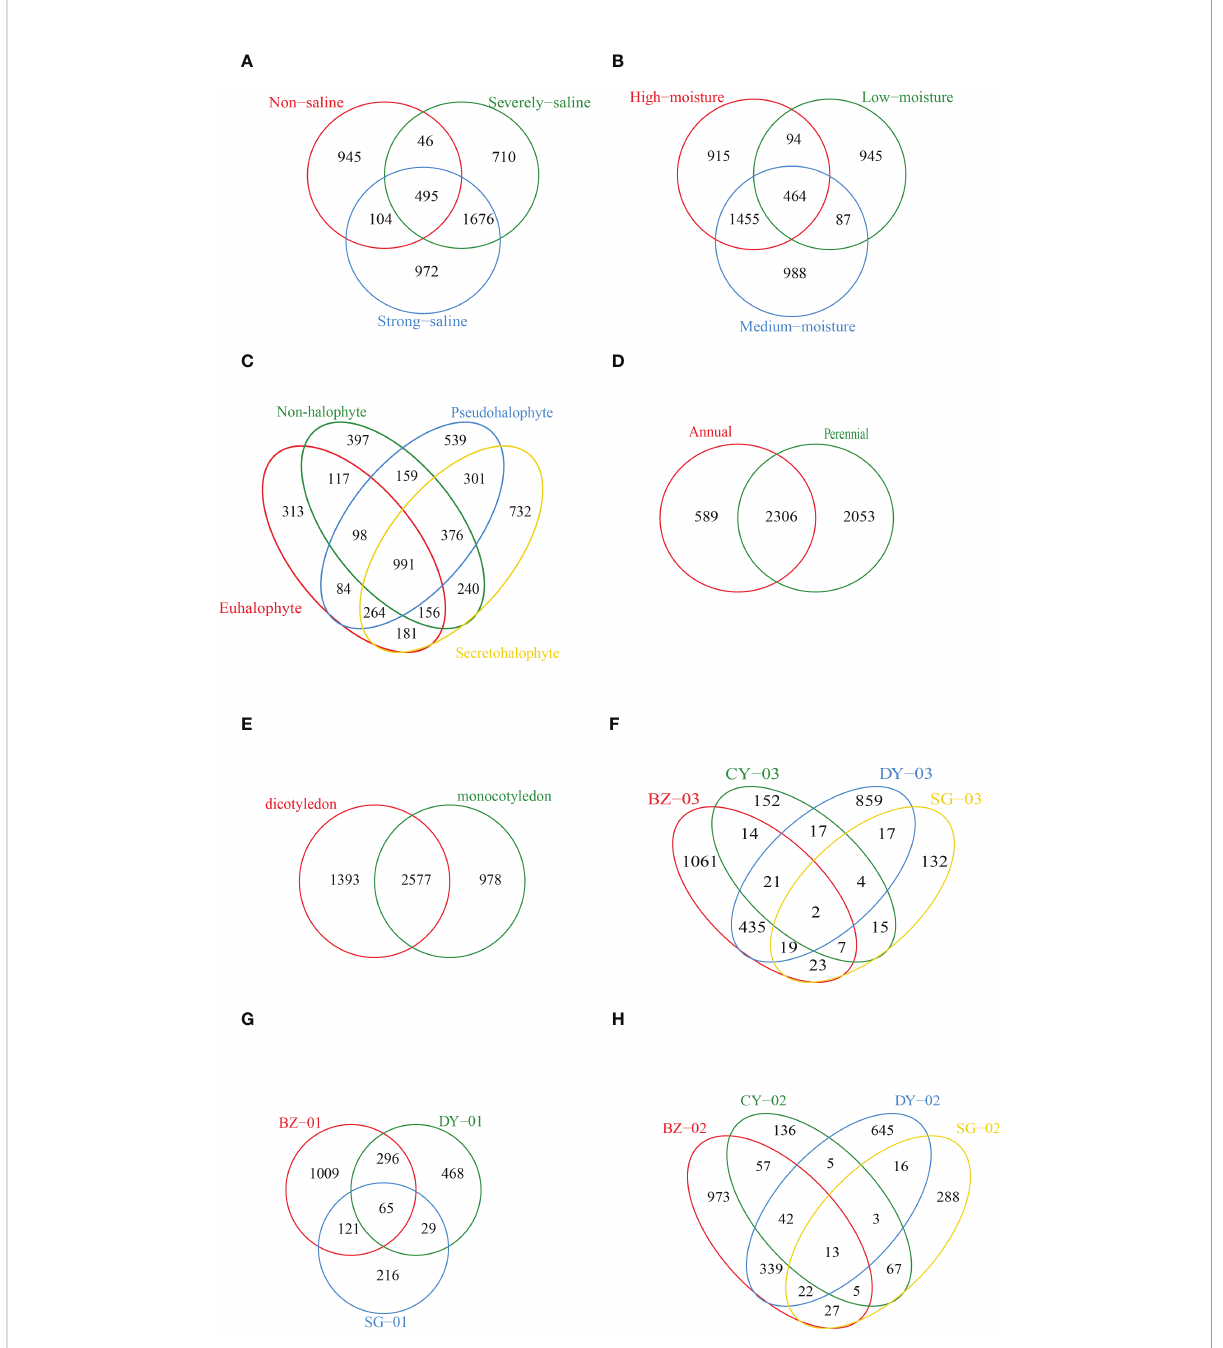
FIGURE 4 Venn diagrams showing the numbers of shared and unique diazotrophic OTUs among the soil samples. (A) Different salinity levels. (B) Different soil moistures. (C) Different plant types based on salt resistance. (D) Different plant types based on life span. (E) Different plant types based on cotyledon number. (F-H) Soil samples respectively collected from the rhizosphere of Tamarix austromongolica Nakai , Suaeda salsa and Phragmites australis grown at different sampling locations. CY02, CY03, SG01, SG02, SG03, DY01, DY02, DY03, BZ01, BZ02 and BZ03 represent the soil samples respectively collected from Changyi (CY), Shouguang (SG), Dongying (DY) and Binzhou